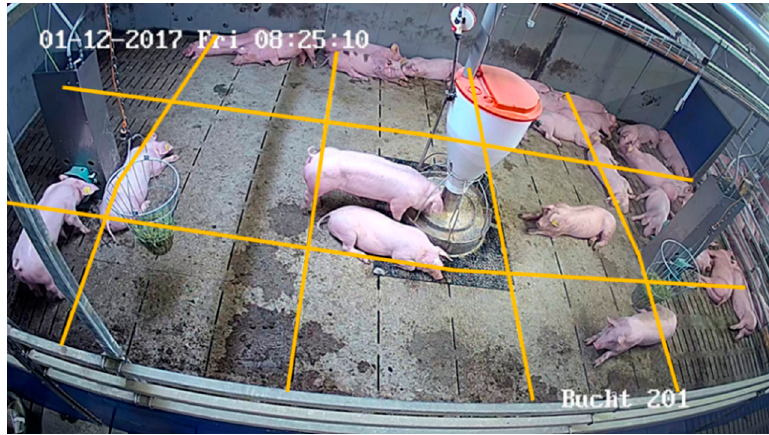
Figure 4. Fifteen segments of pen 201 to determinate the lying behavior and the fouling.